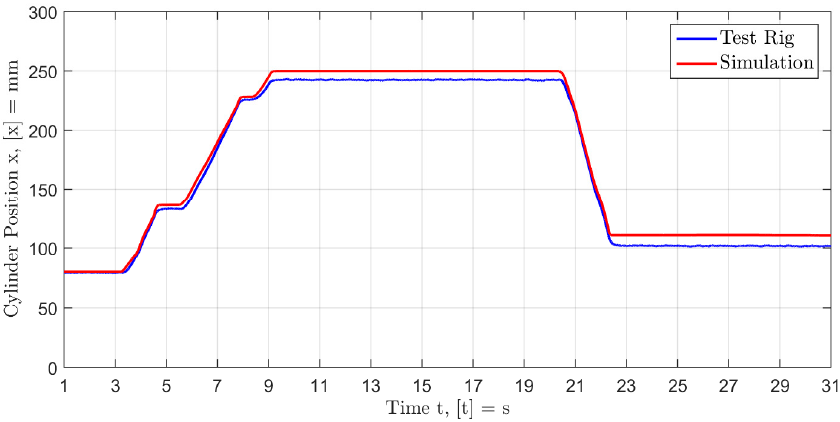
Figure 16. Cylinder position x, Section 2 [9]. Reproduced with permission from the publisher.